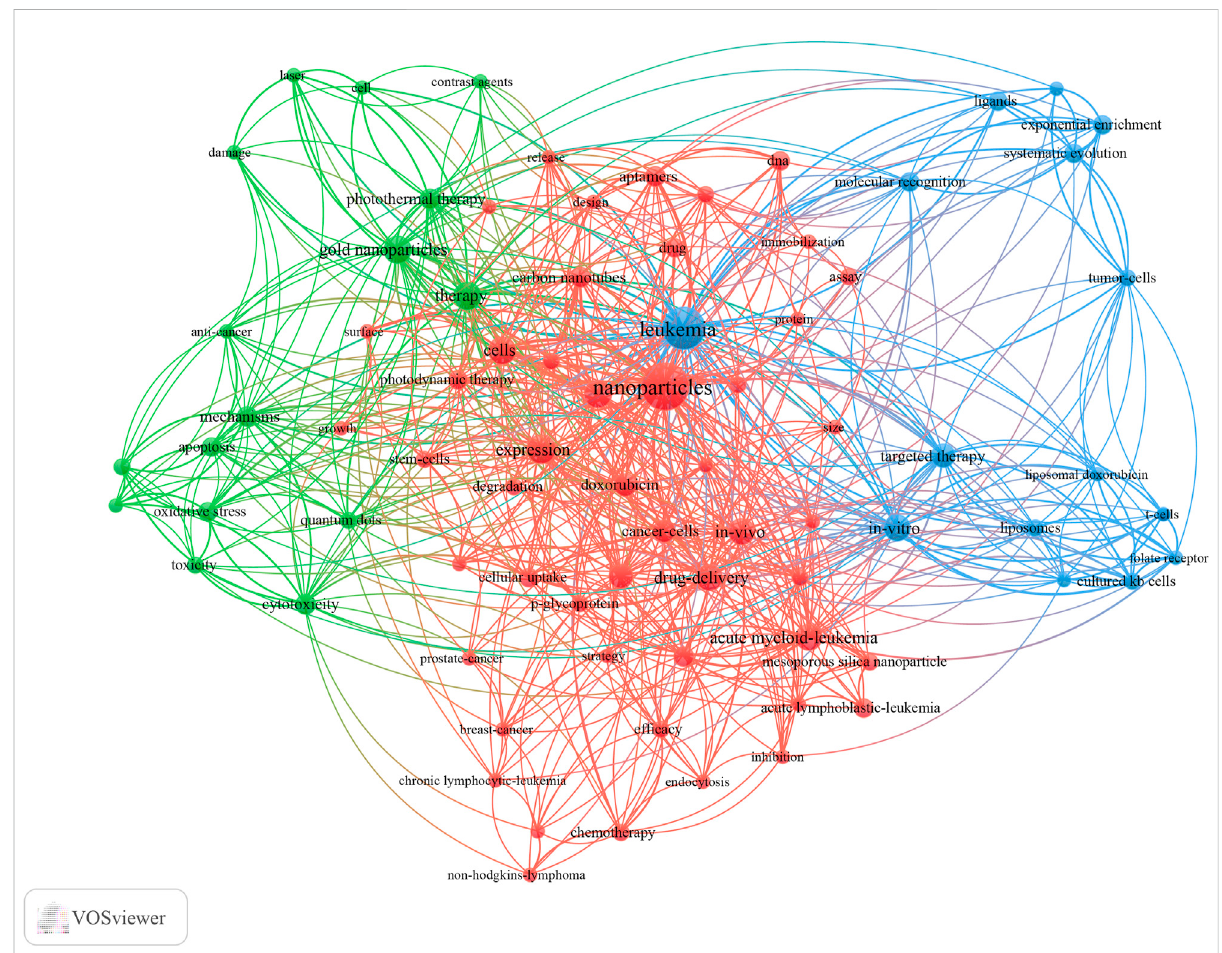
FIGURE 12 Keyword co-occurrence network and clusters in Nanoparticles-leukemia research. Notes: The size of the node and word re fl ects the co- occurrence frequencies, the link indicates the co-occurrence relationship, and the same color of the node represents the same cluster.